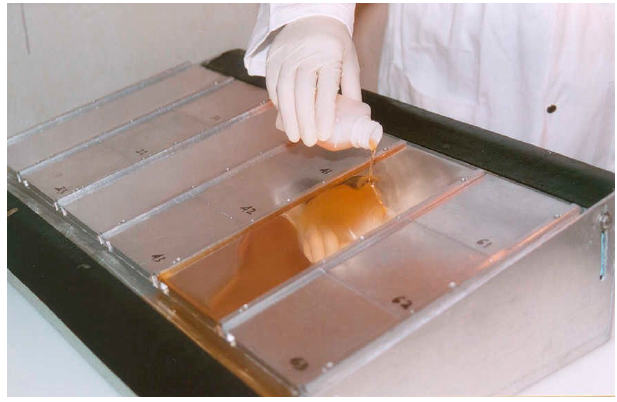
Figure 2. Typical Water Spray Endurance Test (WSET) setup used in the cold room.